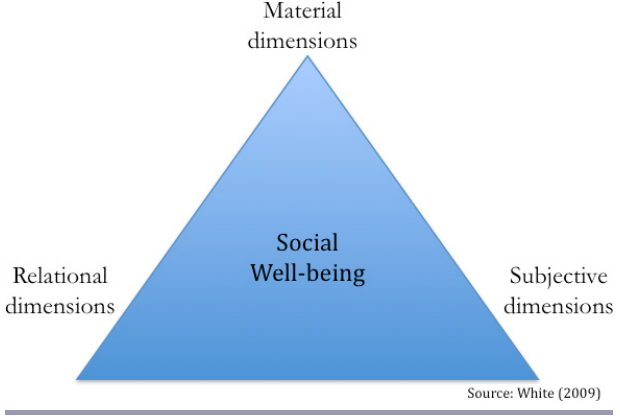
Fig. 1 . Conceptual view of social